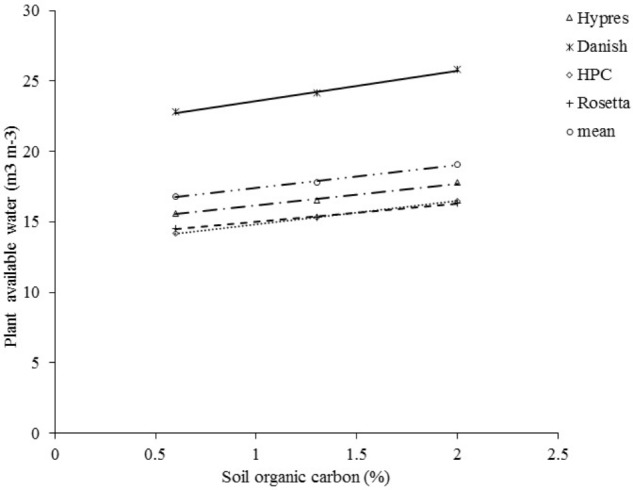
Relationship between plant available water content and SOC at 0.7%, 1.3%, and 2% SOC at LTE-Askov in Denmark. All four PTF functions exhibited linear relationship given by Y = 0.945x + 14.52, R2 = 0.99∗∗∗ (Hypres), Y = 1.309x + 21.319, R2 = 0.99∗∗∗ (Danish), Y = 0.991x + 13.109, R2 = 1∗∗∗ (HPC), and Y = 0.783x + 13.617, R2 = 0.99∗∗∗ (Rosetta).